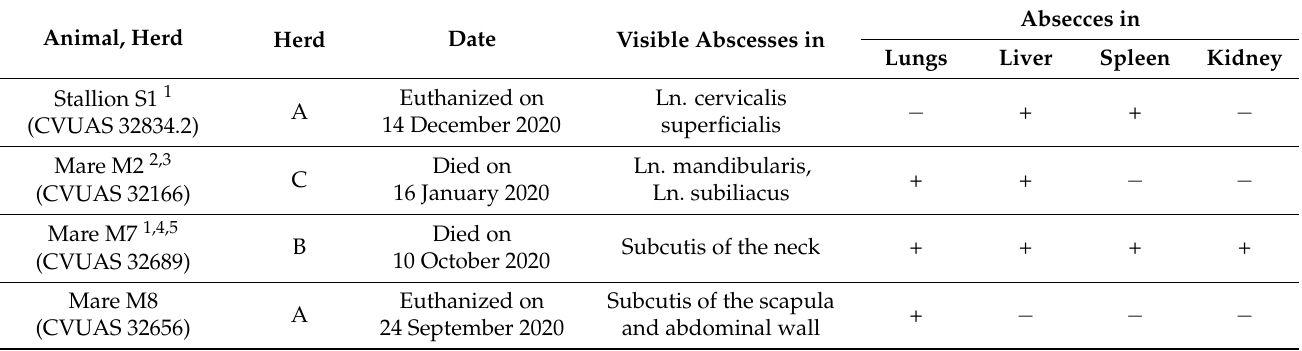
Table 3. Superficial abscesses and internal abscesses detected by post-mortem examinations. The names of the C. pseudotuberculosis isolates are given in brackets in the first